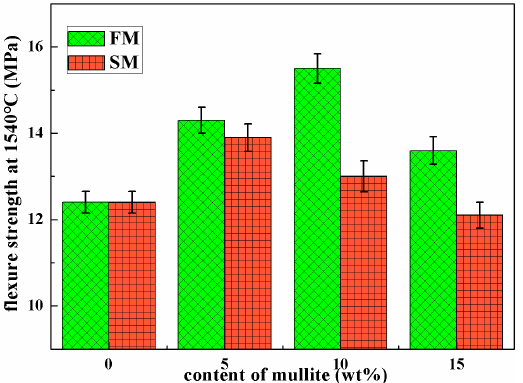
Figure 9. Flexure strength at 1540 °C of the ceramic cores with different amounts of mullite pow- ders.